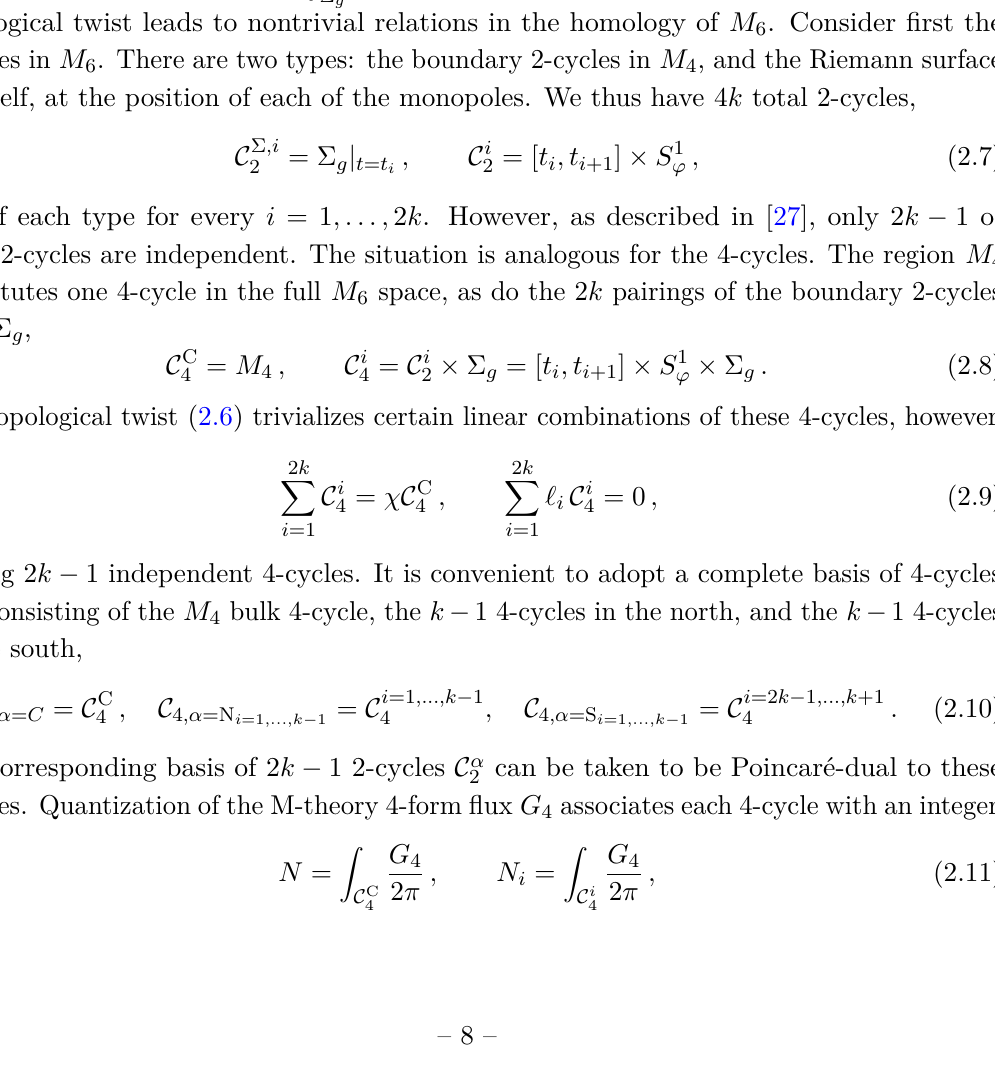
Figure 2. Illustration of the topology of the unresolved S 4 / Z k space ( left ) and resolved M 4 space ( right ), with the ψ and ϕ angles suppressed, taken from [27]. The circle S 1 entire boundary ∂M , while S 1 vanishes only at the 2 k monopoles, labeled by the index i . The blue 2 ϕ bubbles represent the resolution 2-cycles connected by unit-charge Kaluza-Klein